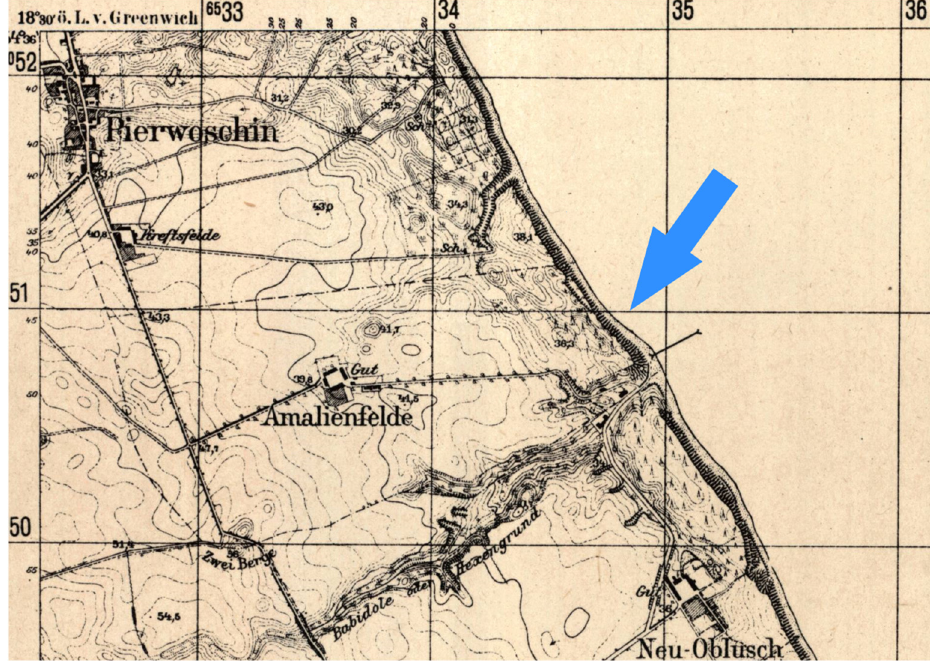
Figure 8. The analysed section of coastline on the map from 1940 (1:25,000). The blue arrow indicates the approximate location of KM 93.6–93.9.